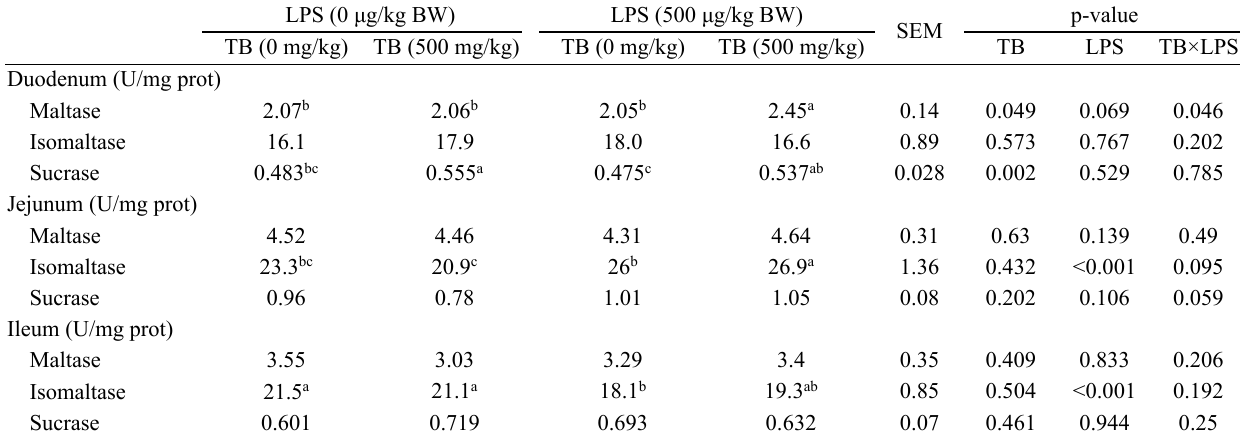
Table 4. Effects of TB on the activities of disaccharidase in the intestine of broilers challenged with